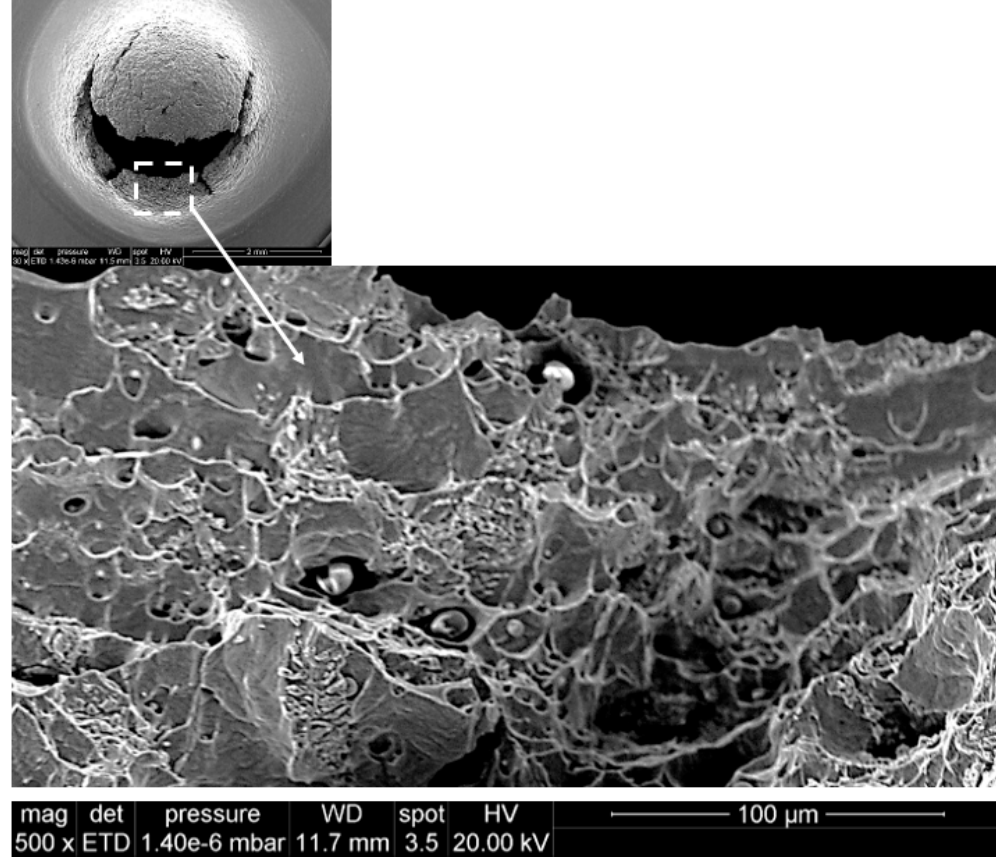
Figure 8. Aspect of typical ductile fracture in SPT specimens.